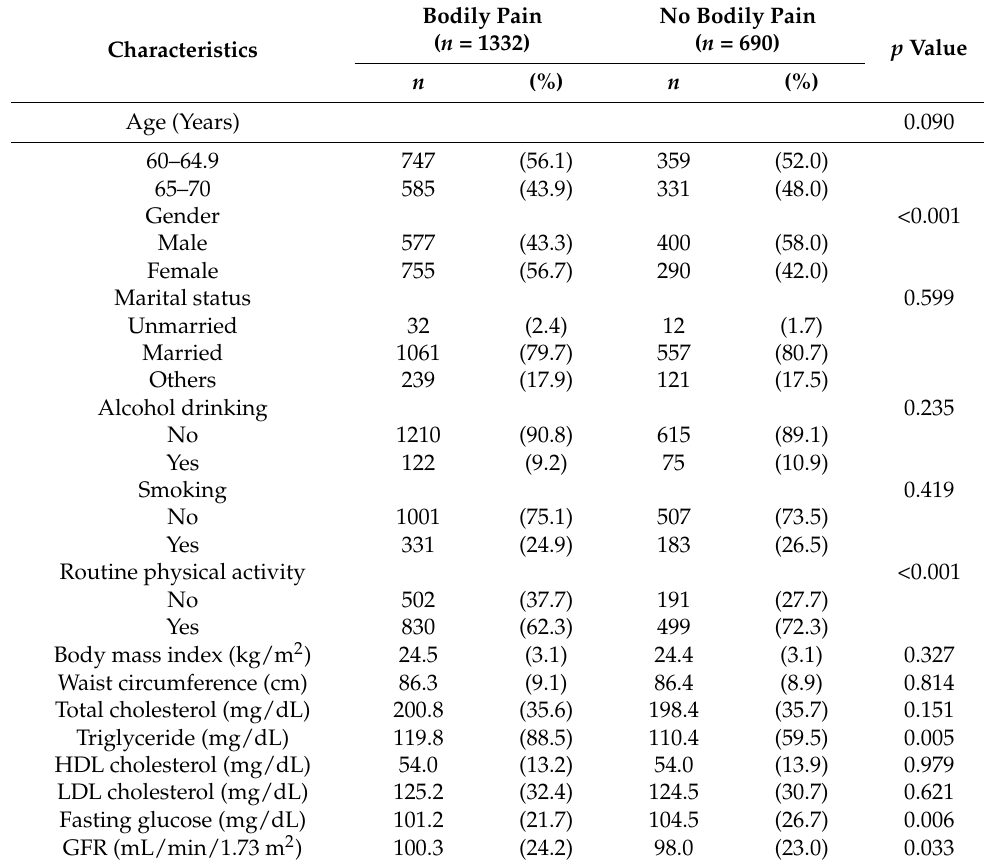
Table 1. Basic characteristics of the study